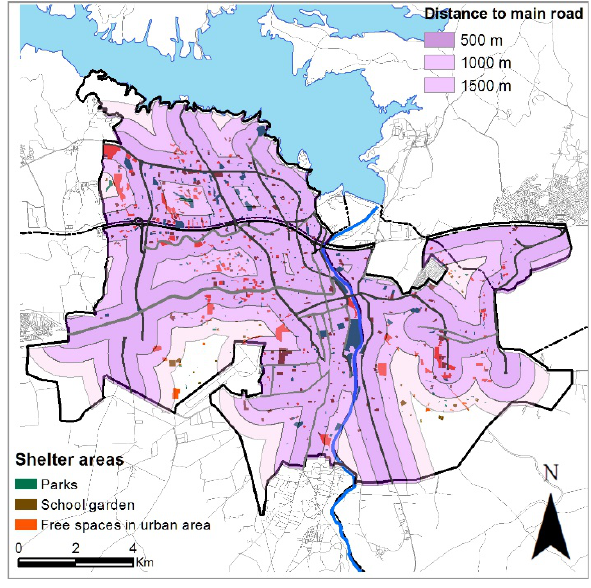
Figure 8: The proximity of major